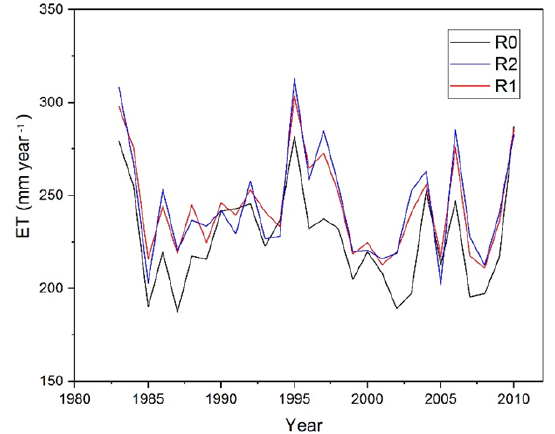
Figure 5. Annual ET simulated under reservoir operation-only sce- narios (R0, R1, and